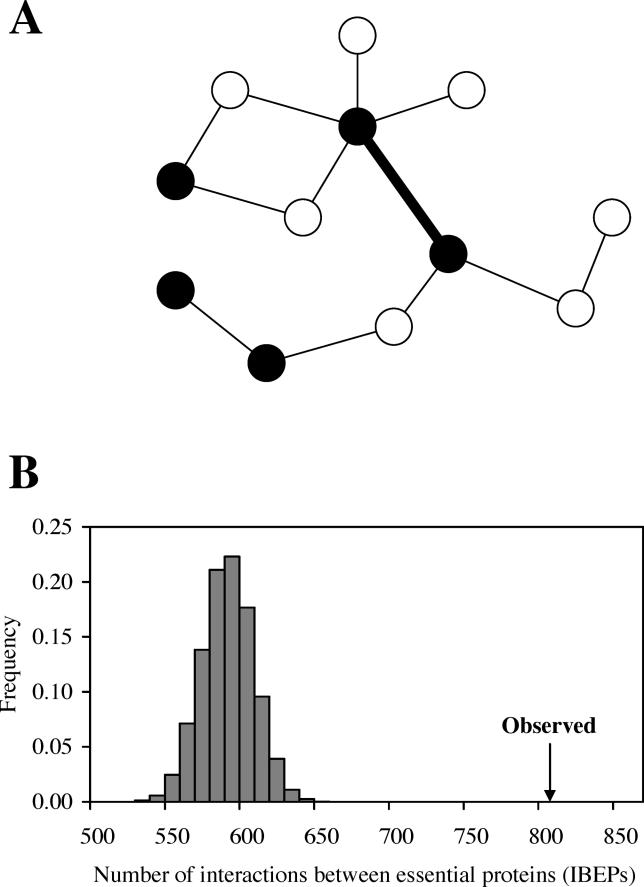
Essential Edges (Interactions) in PPI Networks(A) A hypothetical PPI network of 12 proteins. Black and white nodes refer to essential and nonessential proteins, respectively. Thick and thin edges depict essential and nonessential interactions, respectively. Proteins linked by an essential interaction must be essential, whereas an interaction between essential proteins (IBEP) may or may not be essential.(B) More IBEPs in the yeast PPI network than in randomly rewired networks. “Observed” indicates the observed number (807) of IBEPs in the real network. The gray bars show the distribution of the number (m) of IBEPs in 10,000 randomly rewired networks.